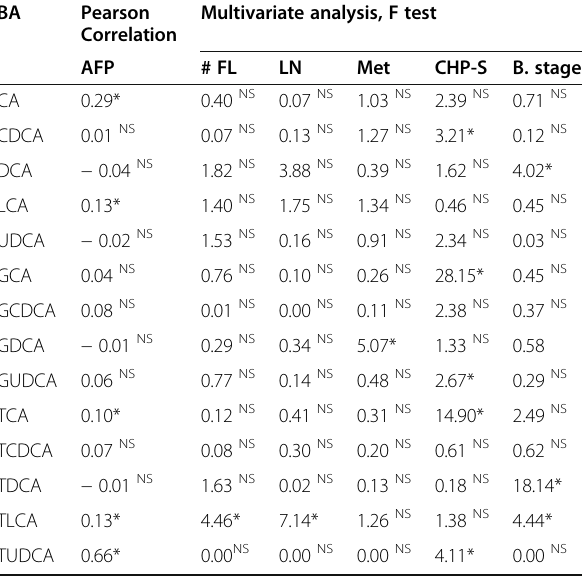
Table 4 Bile acids correlation analysis with AFP and their multivariate analysis with HCC clinical